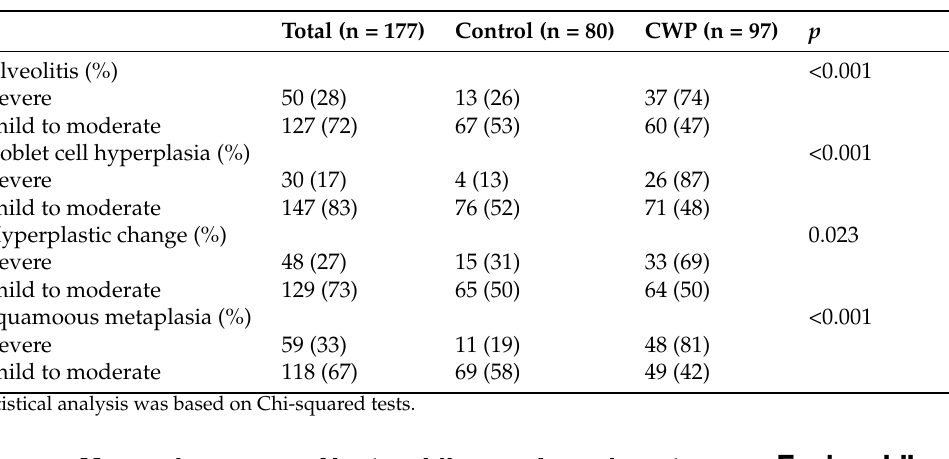
CWP, coal workers’ pneumoconiosis. Table 3. Pathologic findings of bronchoalveolar lavage and bronchoscopy exfoliative cytology from coal workers’ pneumoconiosis.